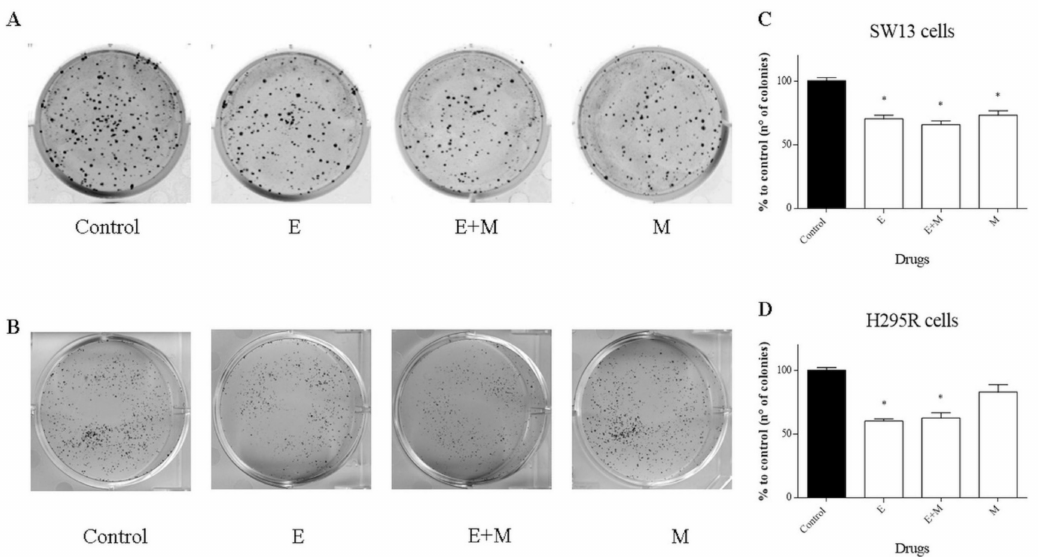
Figure 6. Representative clonogenic assay in SW13 and H295R cells treated with EF24, mitotane, and their combination at 24 h and 72 h, respectively. ( A ) SW13 cells. ( B ) H295R cells. ( C , D ) Statistical analysis (C = control, E = EF24, M = mitotane, E + M = EF24 + mitotane). Treatment vs. control: * p < 0.05. Each experiment was performed in triplicate and repeated